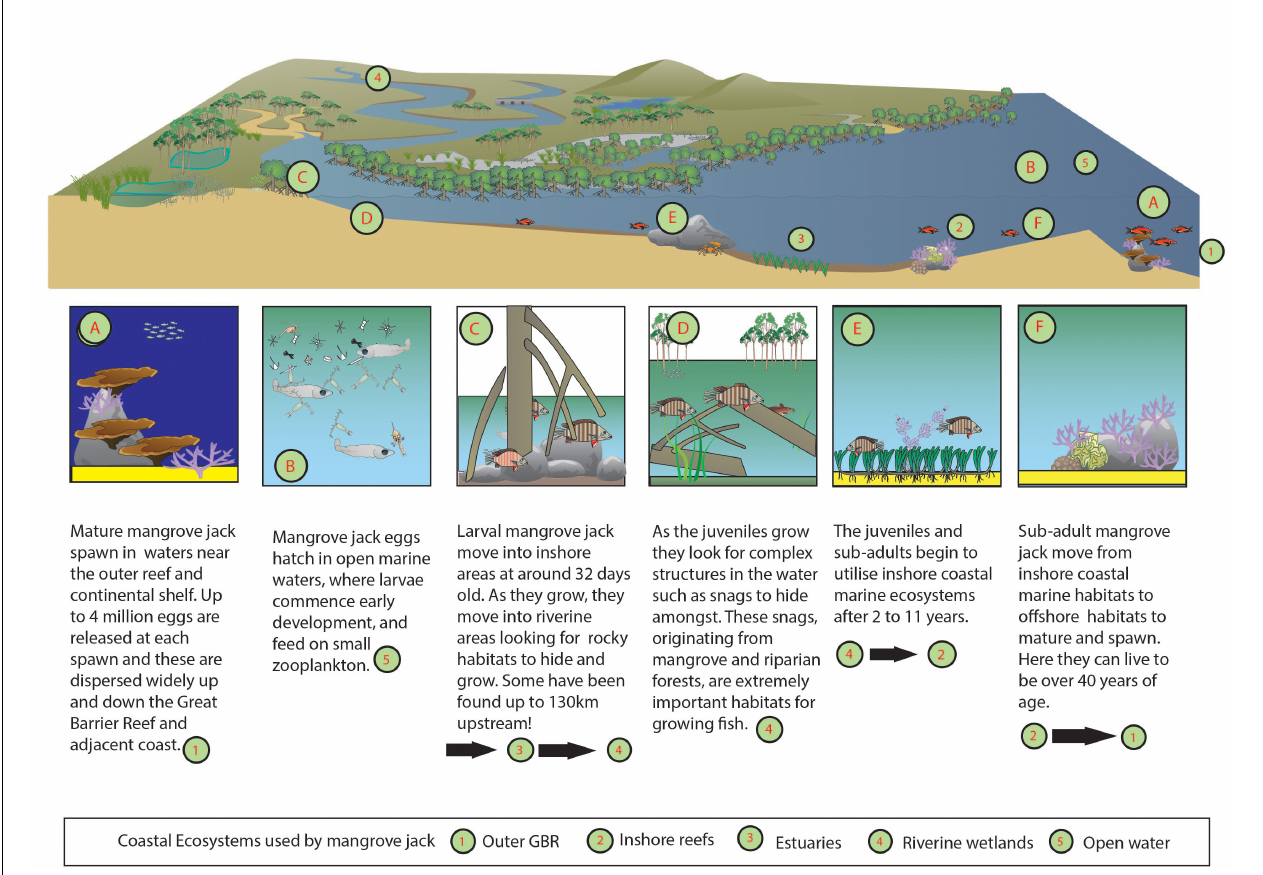
FIGURE 4 | Lifecycle of the mangrove jack ( Lutjanus argentimaculatus ) outlining critical need for access to freshwater and marine coastal wetland areas to complete lifecycle stages. This lifecycle outlines that any disturbance in the seascape, that prevents access to habitats may implicate successful reproduction success for this diadromous